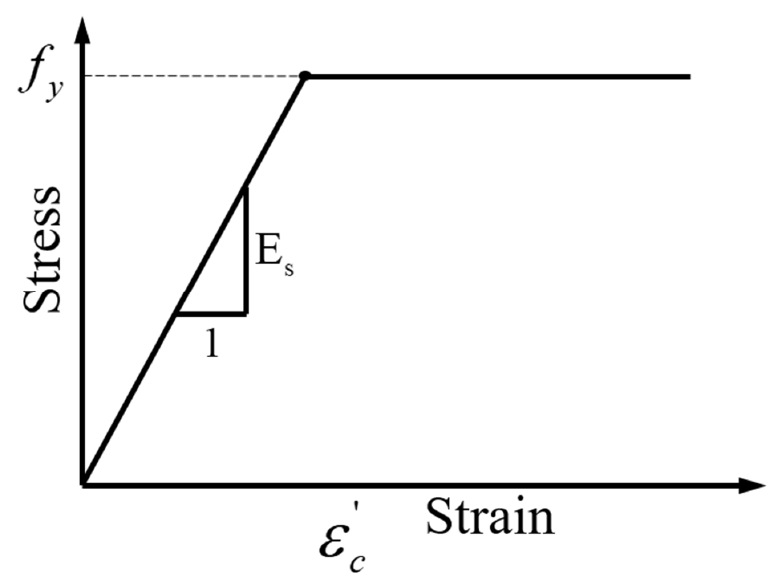
Figure 8. The stress-strain relationships of reinforcement. The RC slab–column joint without punching shear reinforcement presents a rigid- plastic failure form when punching shear occurs [60], and the failure area forms a punching cone (Figure 9). In this paper, the effect of the parts which directly contact the surface of the column (part Ⅰ ) is not considered. Only consider the part of the cone connected with the column (part Ⅱ ) and 4 prisms can be taken as the free-body. One of the prisms free-body is shown in Figure 10. Then integrate the stress on the surfaces (part Ⅲ ) of the prisms to represent the punching shear strength.